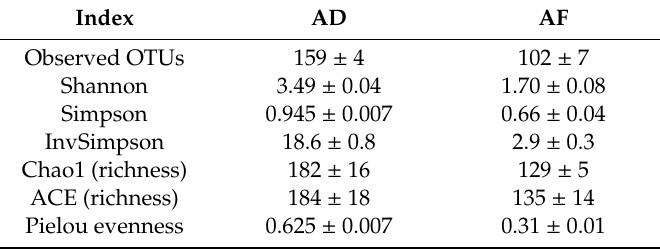
Table 3. Alpha-diversity indices for the microbial community in the AD and AF reactors. Averaged over duplicate samples and calculated based on 20,314 reads per